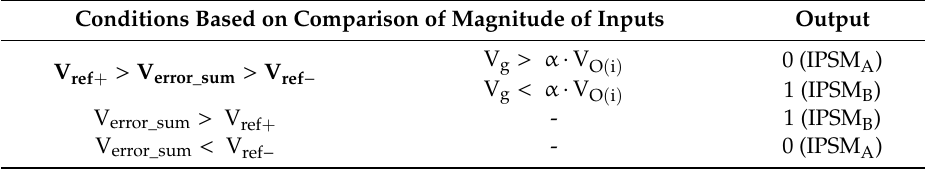
Figure 6. Block diagram of the proposed EDRC. Black lines with an arrow represent an analog signal, and gray lines with an arrow represent a digital signal. Table 1. Truth table of output of inductor power switching mode (IPSM) block.